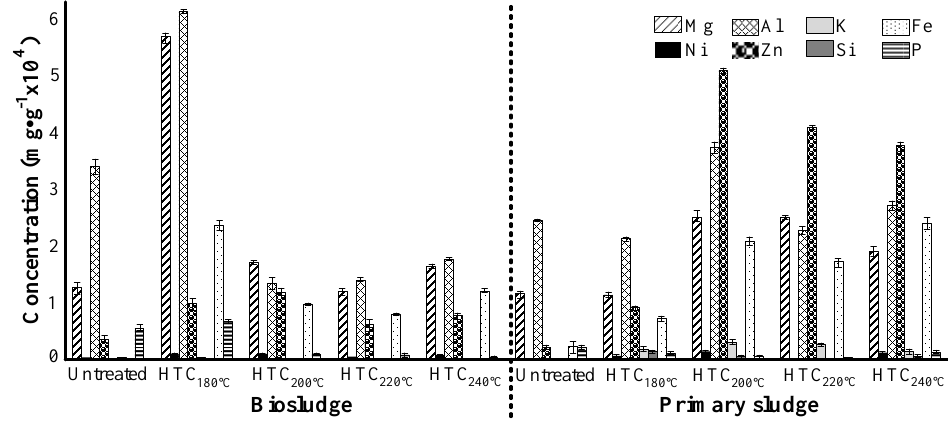
Figure 4. Heavy metals in feedstock and hydrochar BS and SP samples.